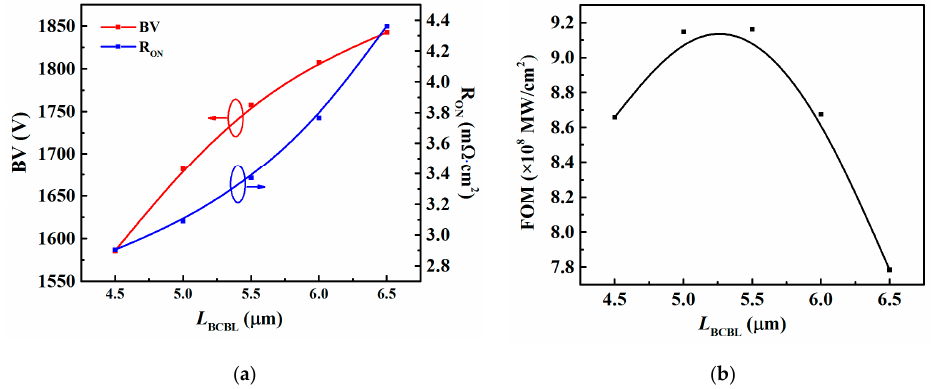
Figure 6. ( a ) BV and R ON versus L BCBL (the length of the BCBL) and ( b ) FOM values versus L BCBL .